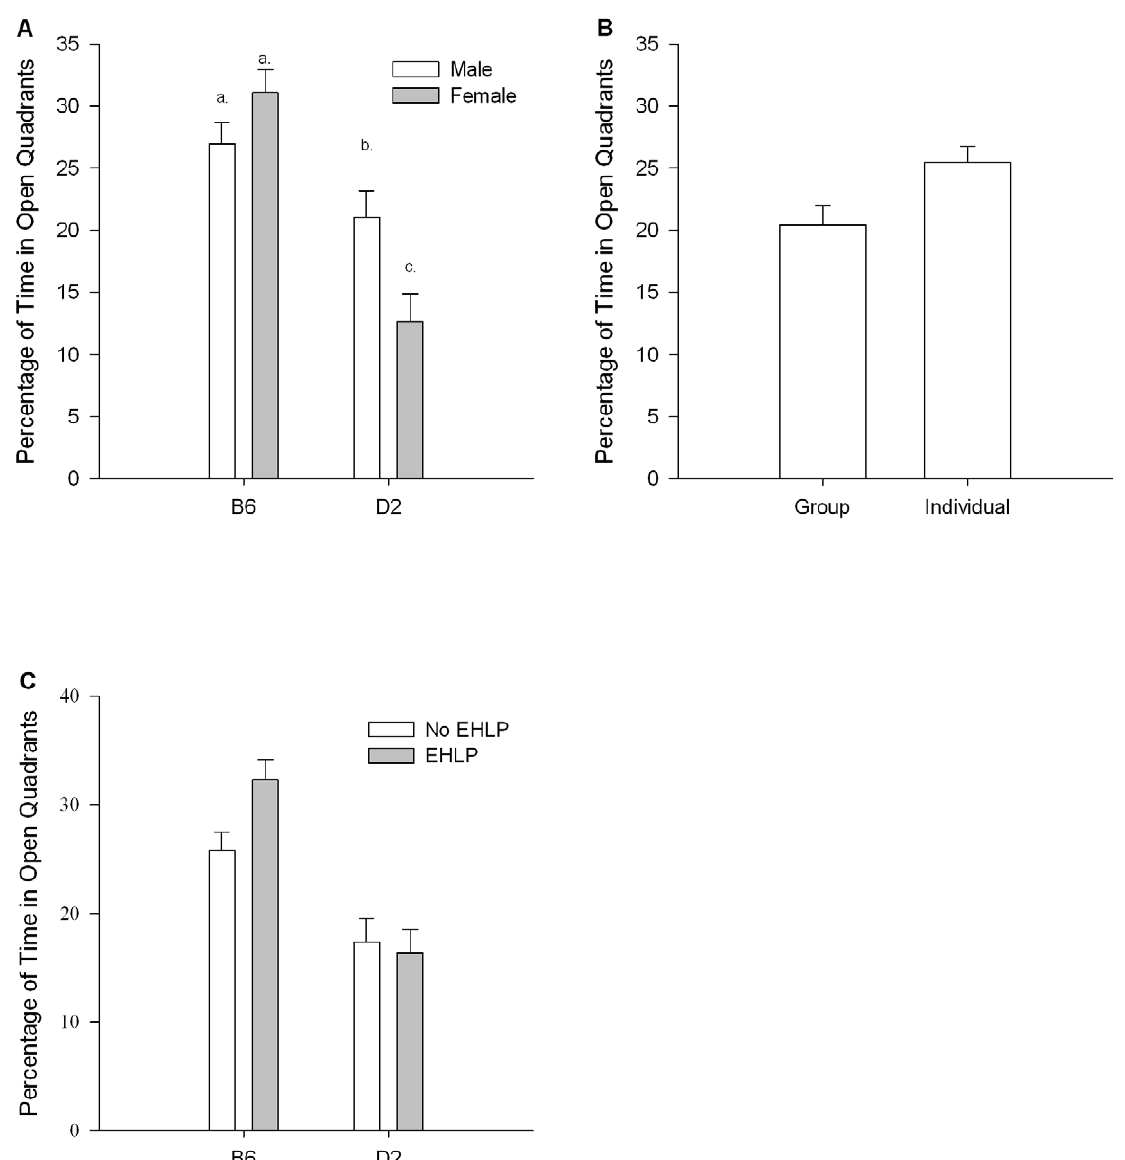
Figure 1. Percentage of Time in Open Quadrants of Elevated Zero-Maze. Data are presented as means 6 SEM . A . Sex x strain interaction. Groups that do not share a common lowercase letter are significantly different at the level, p , .05. B . Main effect of housing, p , .05. C . Interaction of Strain x Handling. The effect did not quite reach statistical significance, p =.065. B6 = C57BL/6J, D2 = DBA/2J, Group = Group Housed, Individual = Individually Housed, No EHLP = undisturbed other than routine animal care, EHLP = Early Handling Like Procedure.